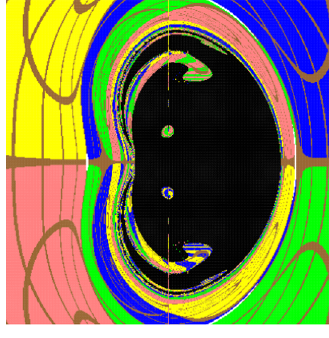
Figure 8 . The black hole shadow for the effective metric (2.22) with α = which shows that the main eyebrow is disconnected from the main shadow. Here we set the black hole M = 1 and the observer locates in the position with r obs = 50 M and θ obs = π/